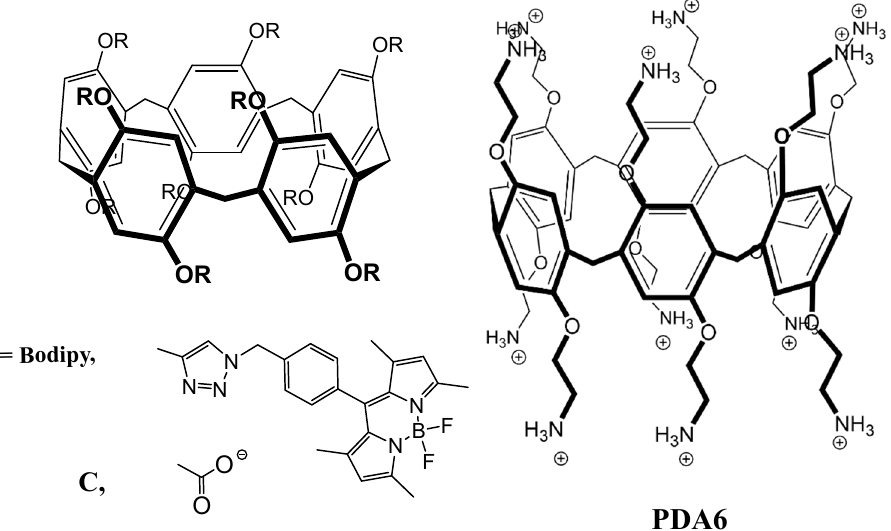
Figure 5. Structure of the Pillar[5]arene receptors, P5-Bodipy [95], carboxylatopillar[5]arene, C-P5 [26], and dodecaamine pillar [6]arene, PDA6 [51].